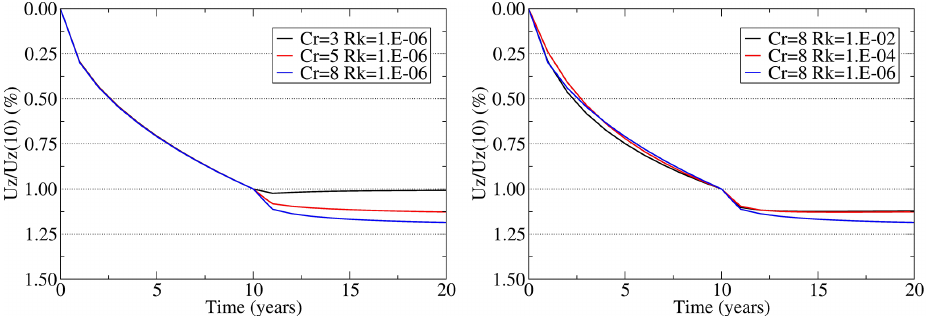
Figure 5. Maximum vertical displacement U z normalized with respect to the displacement at the end of the pumping period (10 years) U z (10) in the case with H a = 2000m and (cid:49)S s = 10m. In the left panel R k = 1 × 10 − 6 and C r = 3, 5 and 8. In the right panel C r = 8 and R k = 1 × 10 − 2 , 1 × 10 − 4 and 1 × 10 − 6